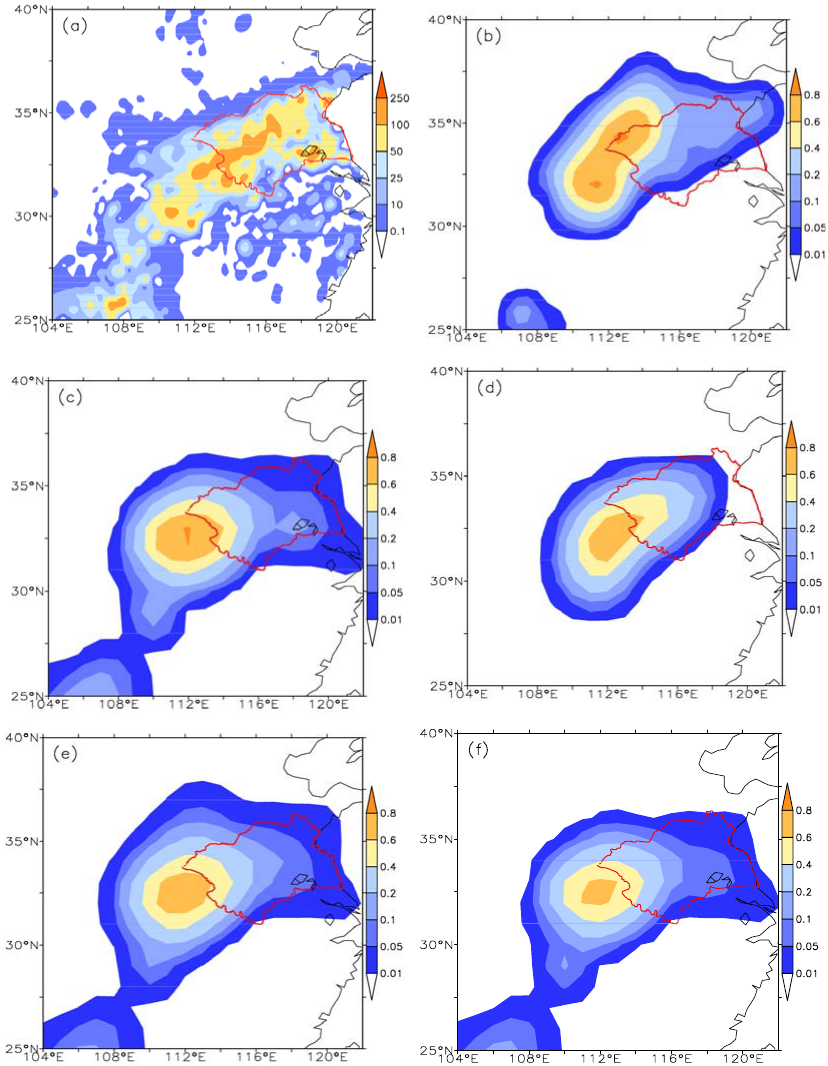
Fig. 5 Precipitation spatial distribution in millimetres of observation (a) and predicted probability of exceeding 50.0mm/24hrs with the EPS of (b) CMA, (c) ECMWF, (d) NCEP, (e) MM-1, and (f) MM-2 with a 1-day lead time.